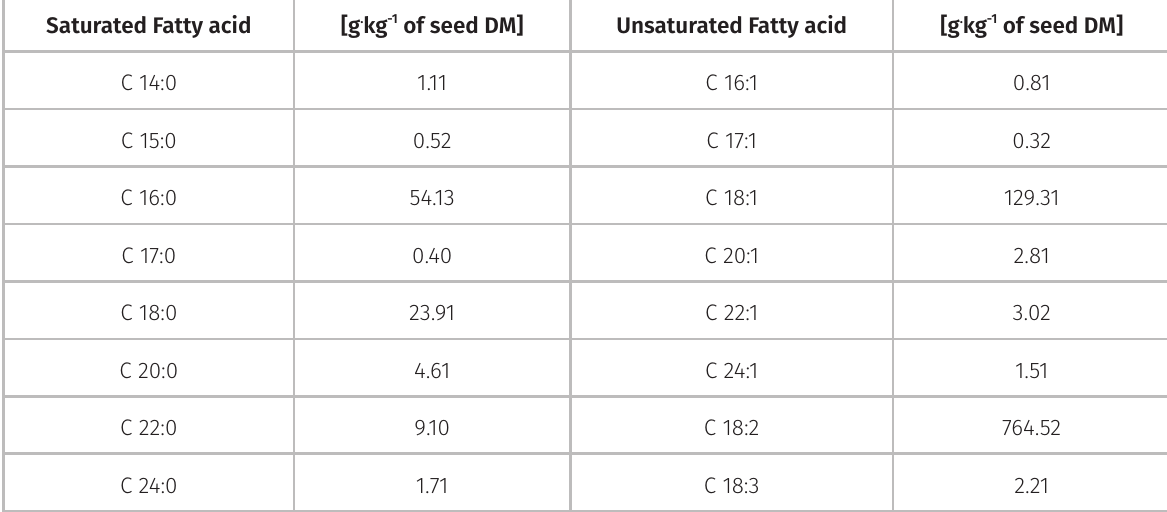
Table II. Fatty acid profile of safflower seed used in the lambs fed diet. Saturated Fatty acid [g . kg -1 of seed DM] Unsaturated Fatty